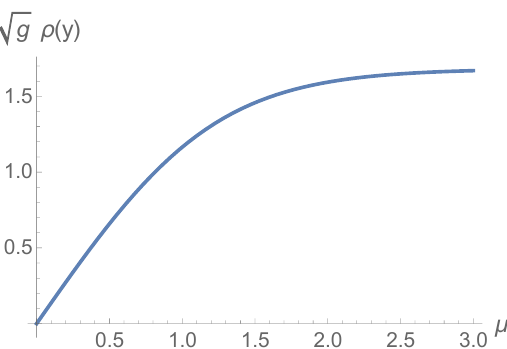
Figure 1. The profile of the radial field ρ ( y ) given in (2.10) that satisfies Dirichlet boundary